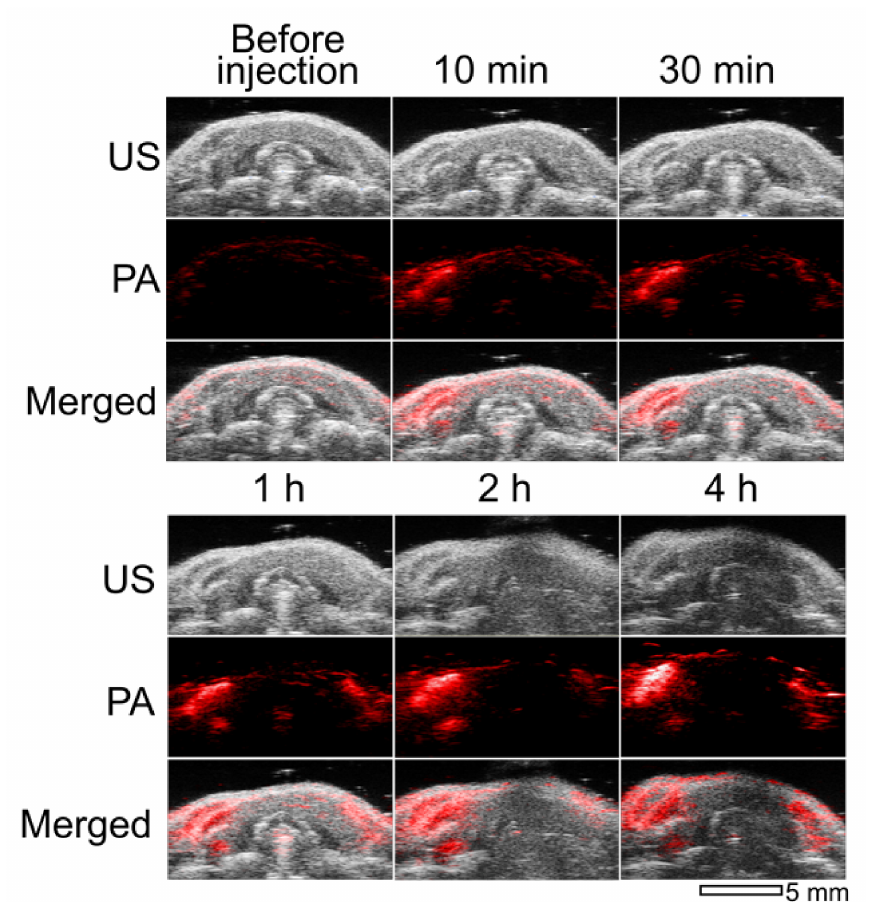
Figure 4. Ultrasound (upper), photoacoustic (middle), and merged images (lower) of cervical lymph nodes of a mouse after injection of GC-AuNPs (2.5 mg Au/mL, 80 µ L). Images were obtained before injection, at 10 min, 30 min, 1 h, 2 h, and 4 h of post-injection. Excitation laser wavelength was 680 nm and laser power 0.62